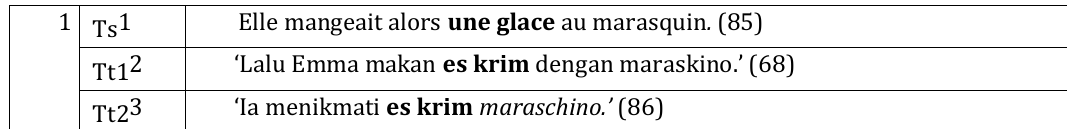
Tableu 1 La traduction directe